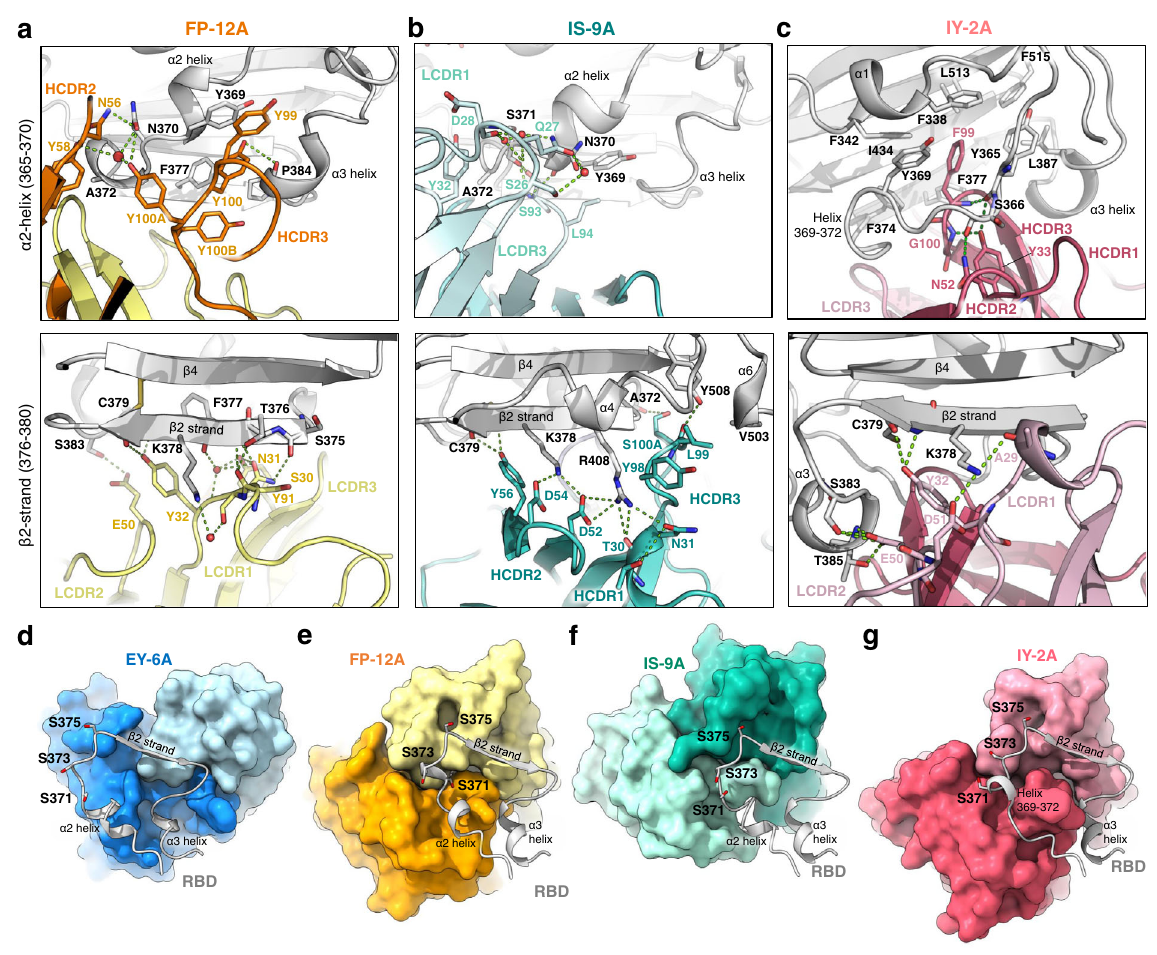
Fig.4|Detailedstructuralinterfacebetweenclass4 antibodiesandRBD.a The interface between FP-12A (heavy chain, orange; light chain, yellow) and two key binding regions on RBD (gray, upper, 365 – 370 α 2 and 384-388 α 3 helices; lower, 376 – 380 β 2 strand). Heavy and light chain CDRs (HCDR and LCDR) and key inter- acting residues are labeled. Hydrogen bonds are shown in green dash lines, and watermolecules inred spheres. b The same viewsofinterface asin ( a ) between IS- 9A (heavy chain, dark teal; light chain, light teal) and RBD (gray). c The same views